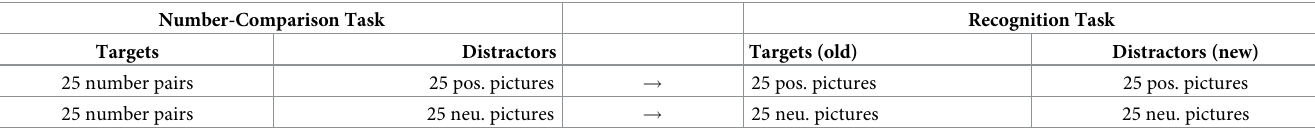
Table 2. Stimuli in the number-comparison task and the recognition